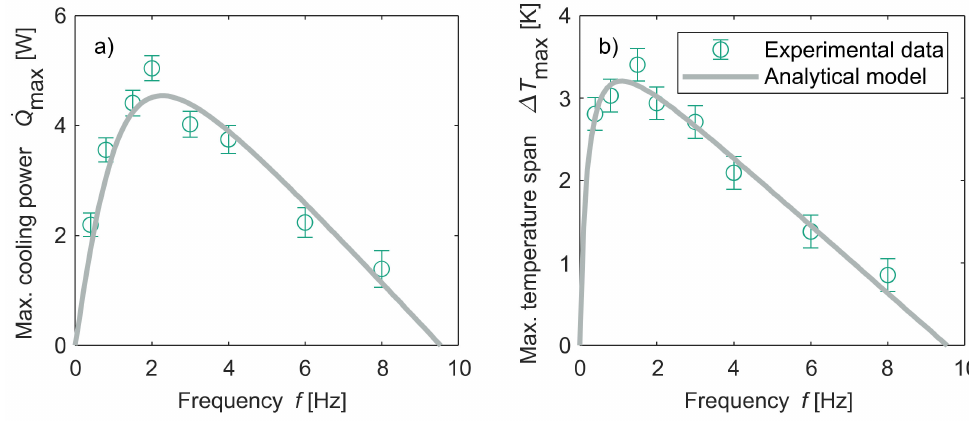
Figure 7. Measurement data and analytical model. ( a ) The maximum cooling power and ( b ) the maximum temperature span in relation to frequency.